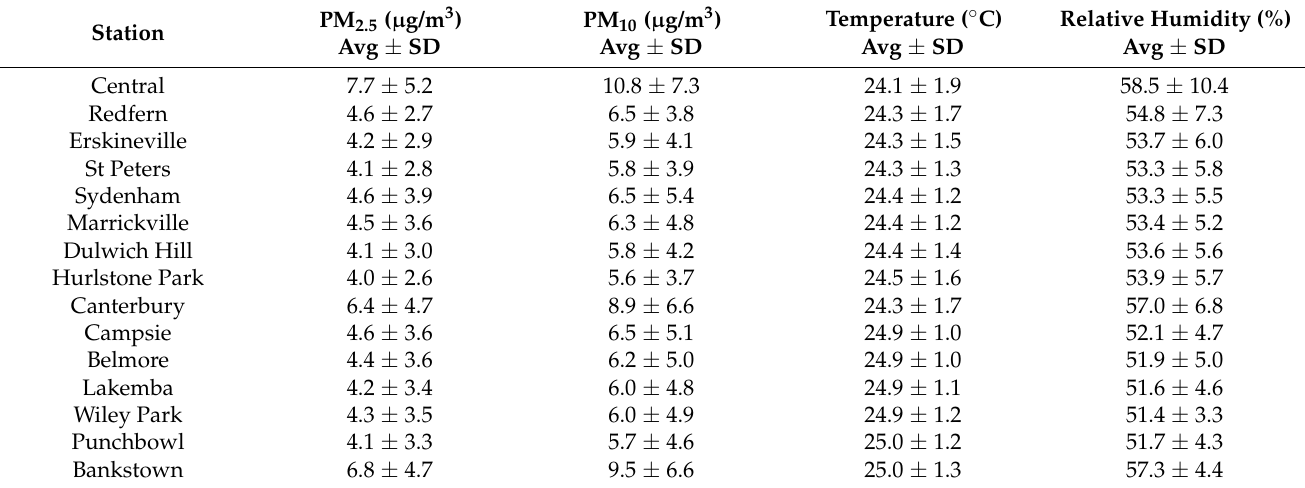
Table 1. Average concentrations of PM 2.5 , PM 10 , temperature, and relative humidity (Average ± Standard Deviation) inside the train carriage on the ground level for over three months from November 2021 to January